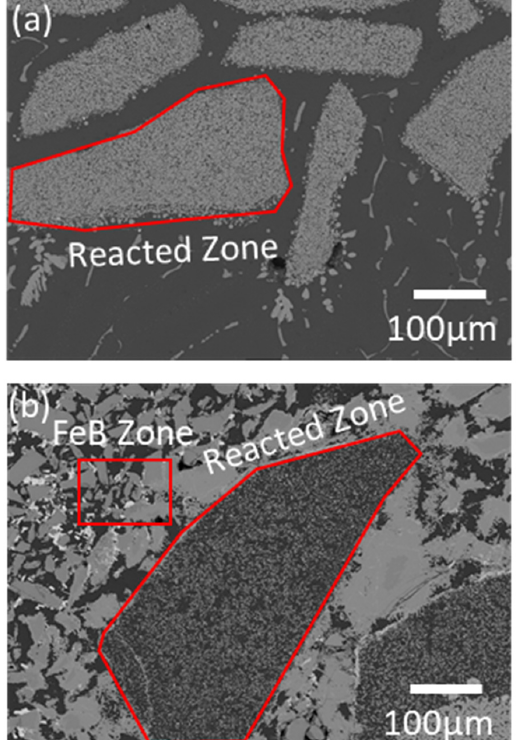
Figure 7. Microstructures after the reaction experiment with ( a ) a conventional LME process and ( b ) FeB-added LME process (×100 magnification). Table 2. EDS results for observing the composition of phases in (1) of Figure 8b and (2) of Figure 8c. Composition (wt.%)